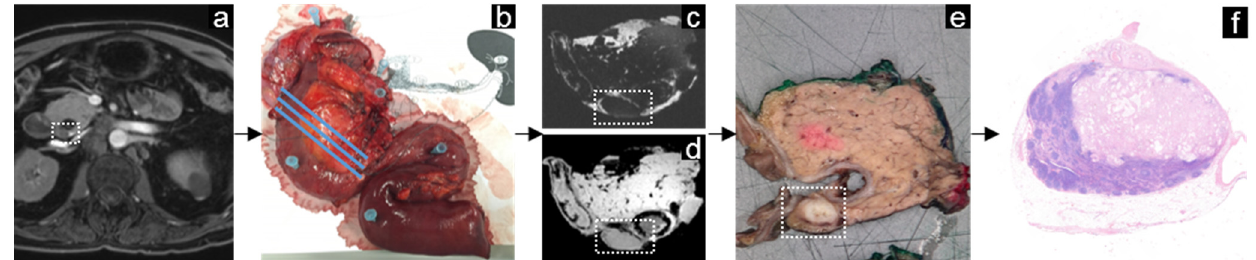
Figure 5. Example of the workflow in periampullary cancer. A transversal view of the T1 VIBE Dixon in vivo MRI showing the pancreas with a suspicious lymph node located dorsally from the pancreatic head in the lined box ( a ). After pancreaticoduodenctomy, the fresh resection specimen was pinned on an anatomical drawing ( b ), and an ex vivo MRI scan was performed, on which the same lymph node could be identified on the lipid-selective image ( c ) and the water-selective image ( d ). The USPIO-surgery interval was 8 days; thus, USPIO was no longer present in the resection specimen and therefore did not elicit any signal intensity changes. After the ex vivo MRI, the specimen was fixated and sliced into 5 mm thick slices ( e ). Histopathologic examination with hematoxylin and eosin staining revealed a metastasis within the lymph node ( f ).